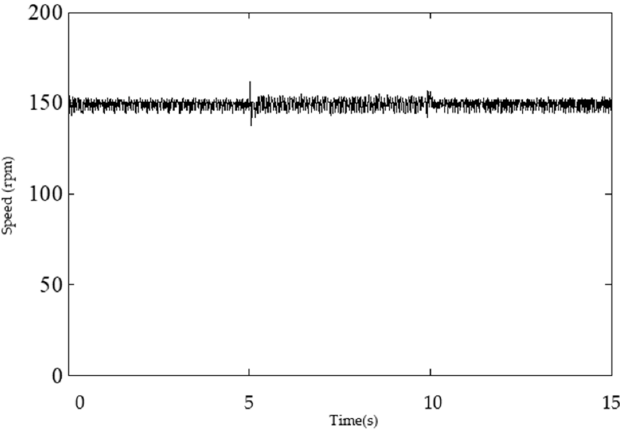
Figure 10. The experimental speed response with load changed